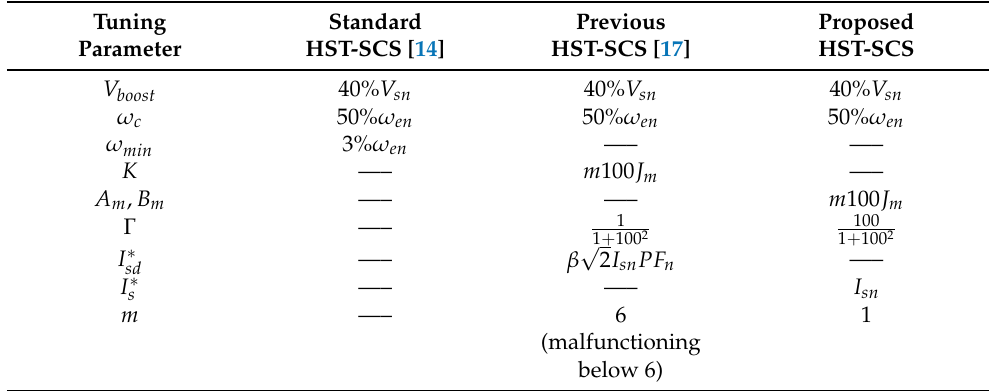
Table 2. Tuning parameters for HST-SCS [17] versus proposed HST-SCS.